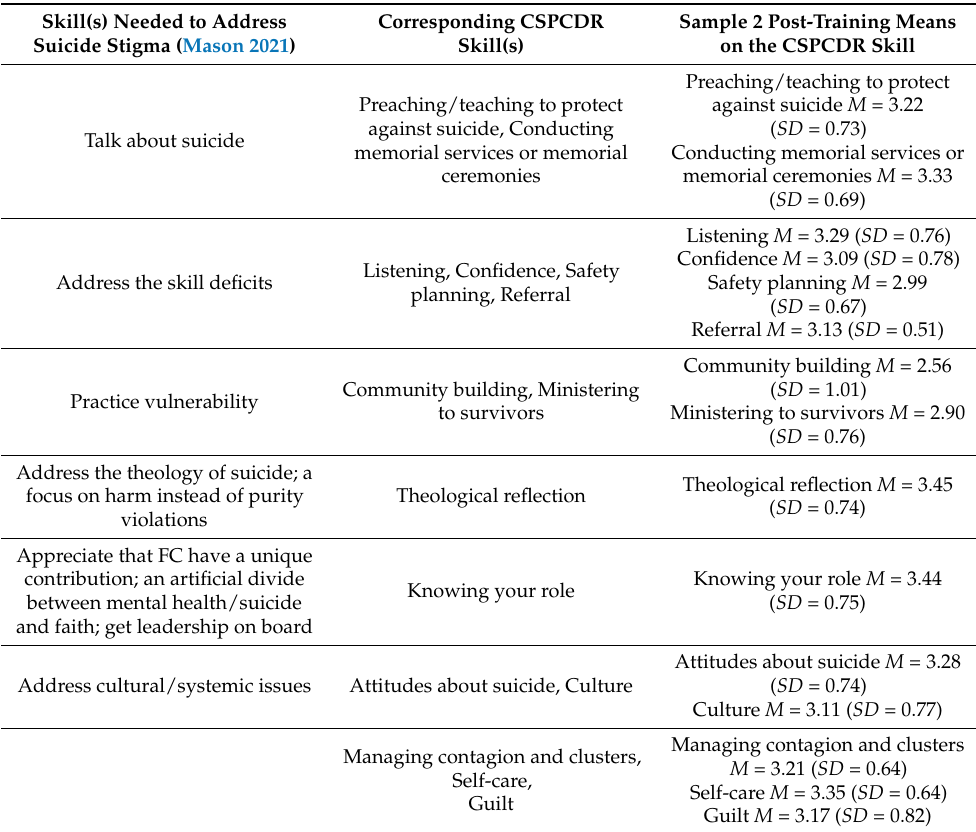
Table 3. FL’ readiness to address suicide